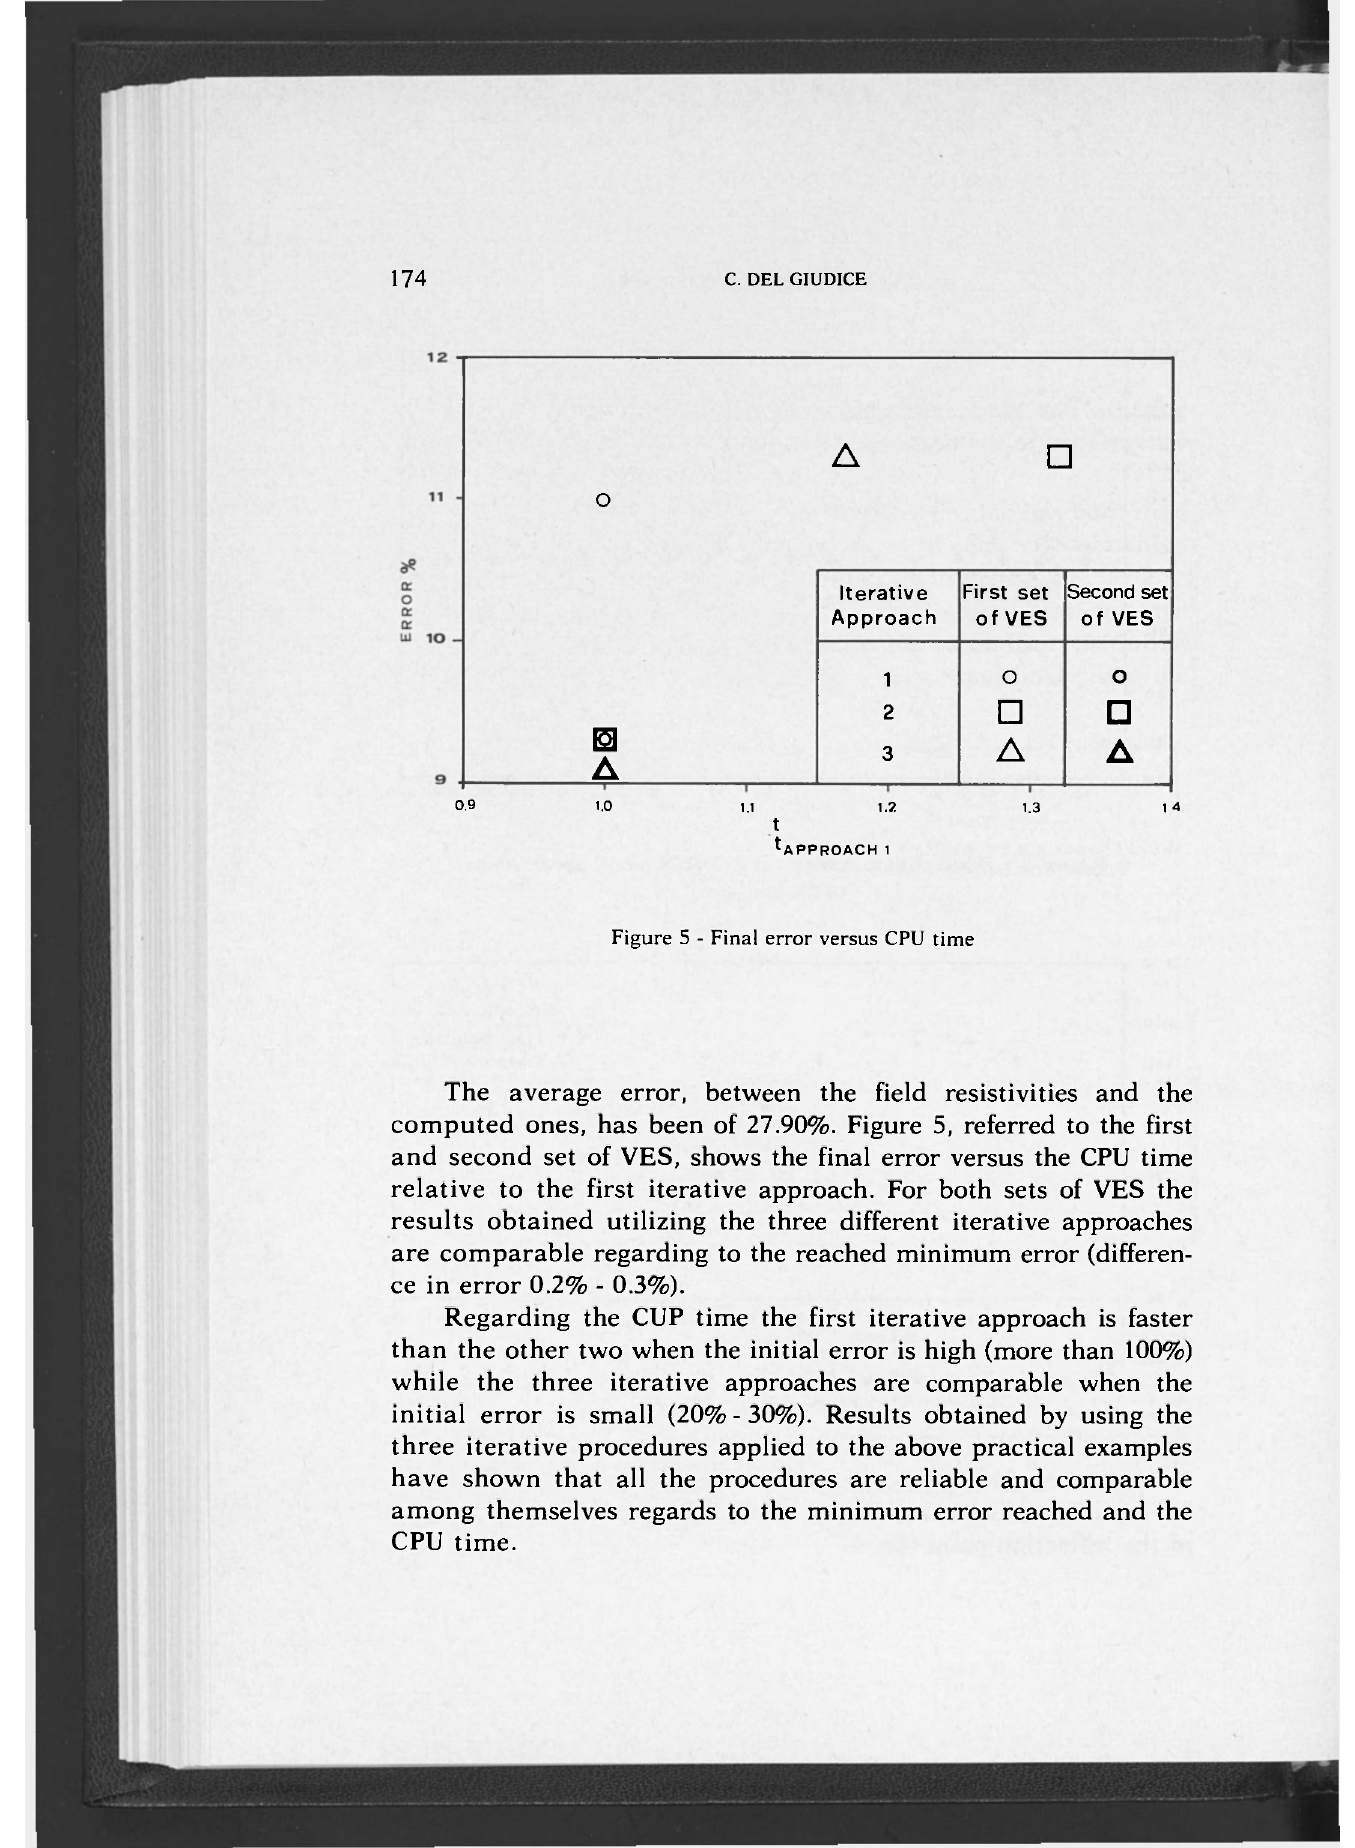
The average error, between the field resistivities and